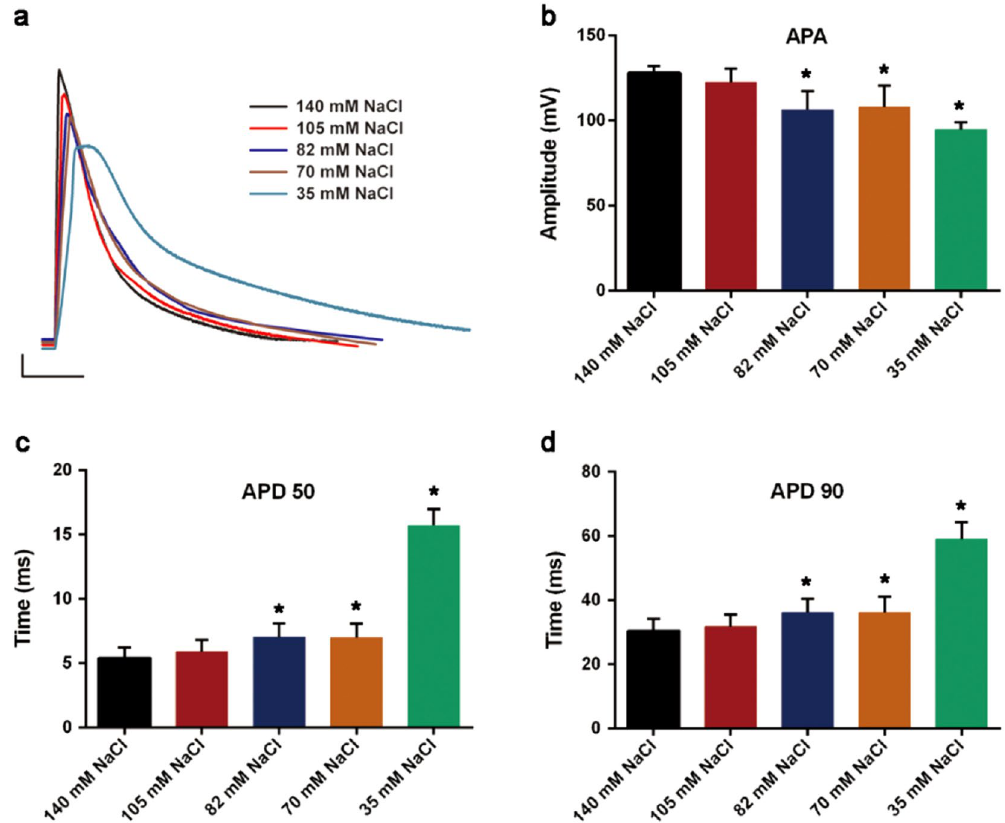
Figure 4. Impact of Na + concentration change in extracellular fluid on AP of cardiomyocytes. When the NaCl concentration in the extracellular fluid decreases from 140 to 105 mM, 82 mM, 70 mM and 35 mM, the changes of AP, APA, APD 50 and APD 90 were shown in the figure (* P < 0.05, compared with the control group). In addition, the APD 50 and APD 90 of the 35 mM NaCl group were compared with the other groups, P ≤